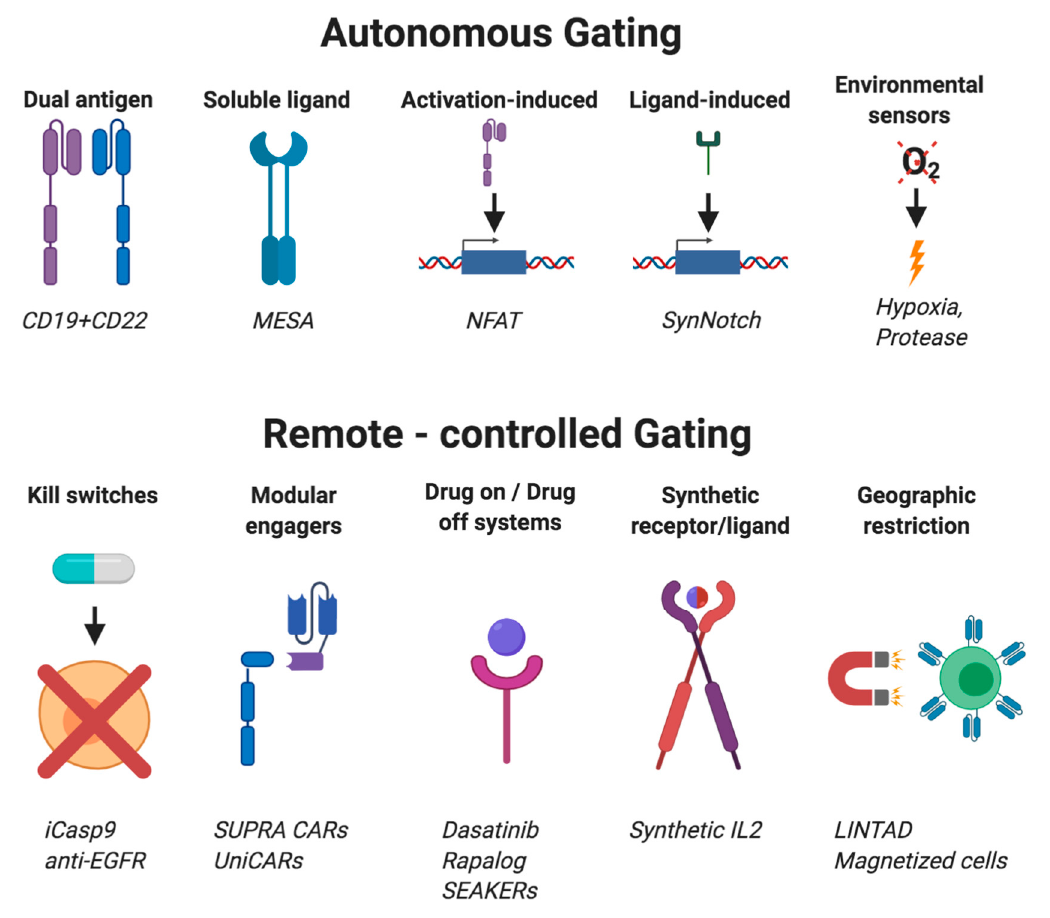
Figure 2. Gating strategies utilized by TCMs. Table 3. Gated “smart” synthetic cell systems.